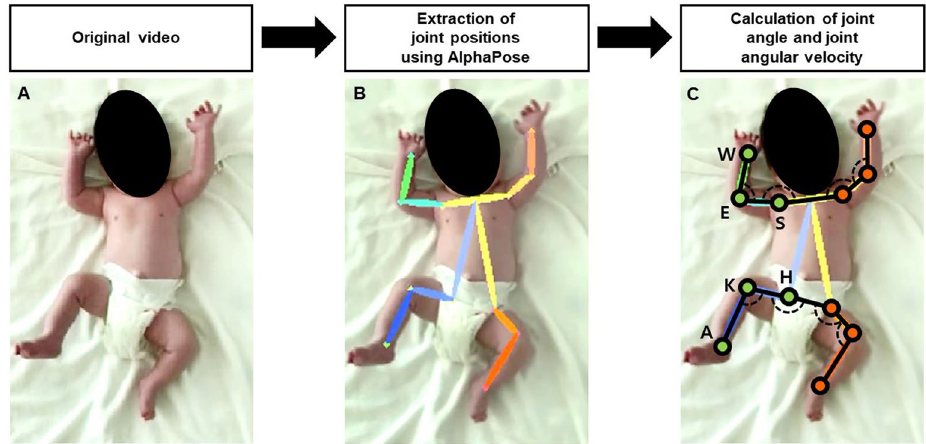
Figure 1. Overall processes of acquisition of joint angles and joint angular velocities at the upper and lower extremities from video images of spontaneous movements in preterm infants. S shoulder, E elbow, W wrist, H hip, K knee, A